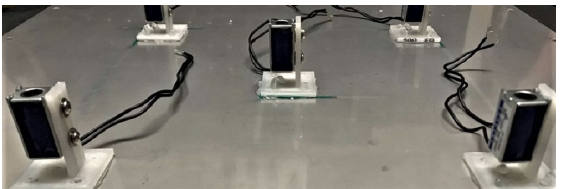
Figure 2. The solenoid coils attached to the incident